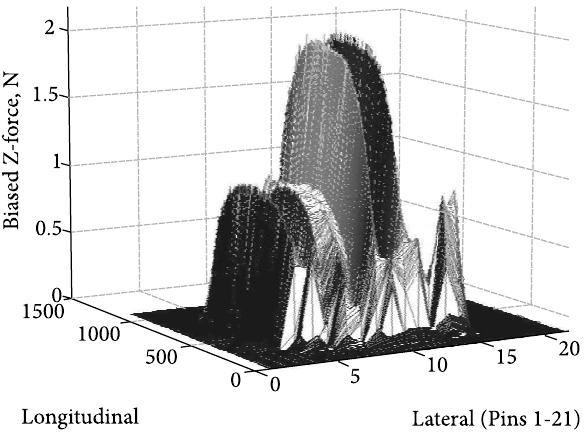
fig. 1. The biased values between the measured and predicted vertical forces for 11 R 24.5 at 27.5 kN tire load and 896 kPa tire inflation pressure